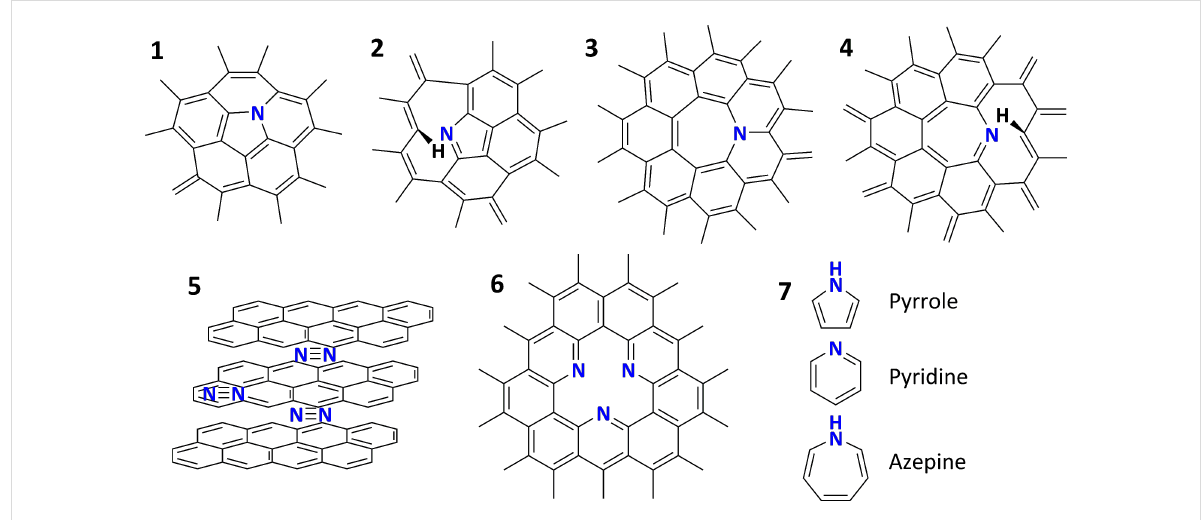
Figure 13: Examples of how nitrogen atoms can be incorporated into the graphene layer: (1) and (3) deformational substitutions; (2) and (4) deforma- tional substitutions with a vacancy; (6) “nitrogen gap” (three ‘pyridinic’-like nitrogen atoms, that all lead to a higher degree of freedom of the lattice); (5) molecules of nitrogen entrapped between adjacent graphene layers. The types of nitrogen-doping can be referred to ‘pyridinic-‘, ‘pyrrolic-‘ and ‘azepinic-like’ in analogy to the nomenclature of simple heterocyclic